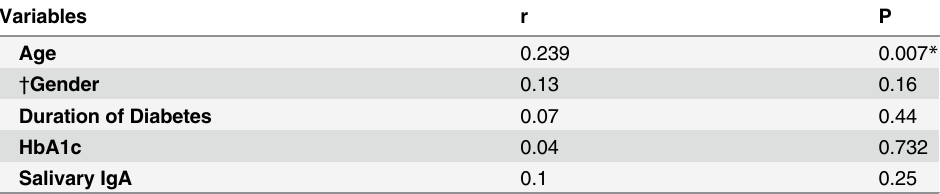
Table 2. Correlation between serum IgA and other variables in diabetic individuals. Variables